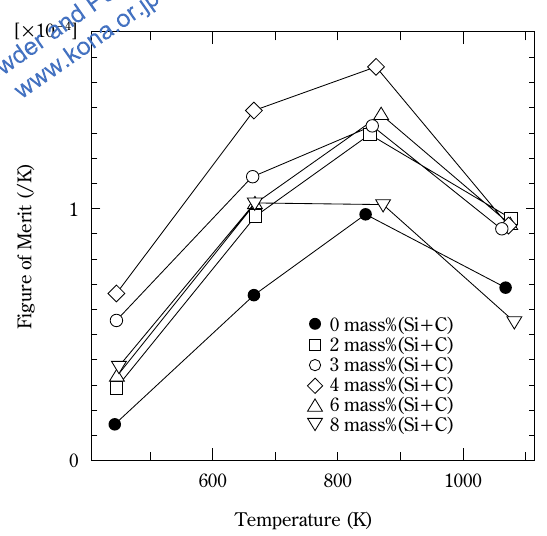
Temperature dependence of the figure of merit for the sintered p-type Fe 0.92 Mn 0.08 Si 2 with addition of x mass% (Si (cid:4) C).